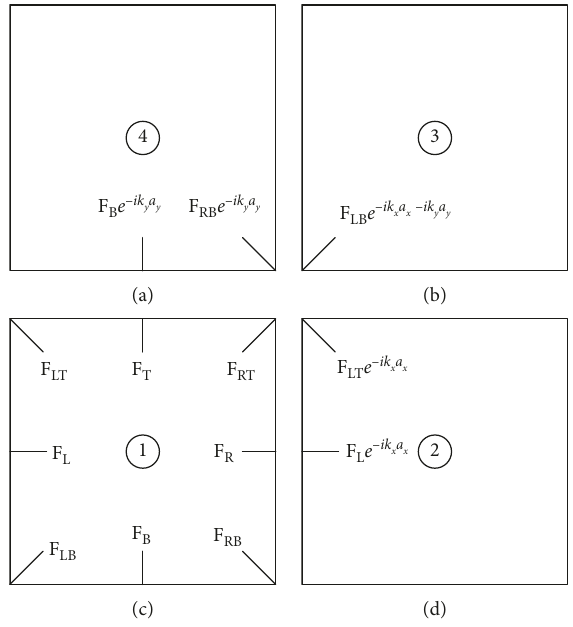
Figure 4: Boundary forces of four adjacent unit